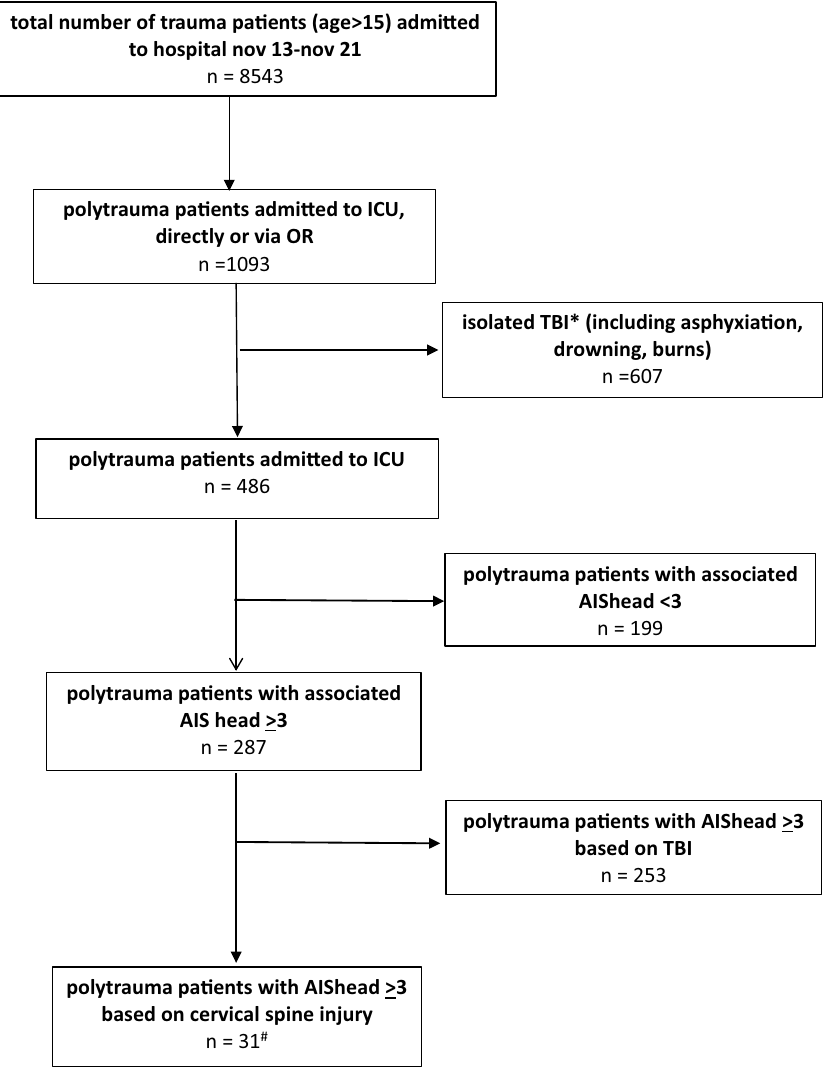
Figure 1. Flowchart of included